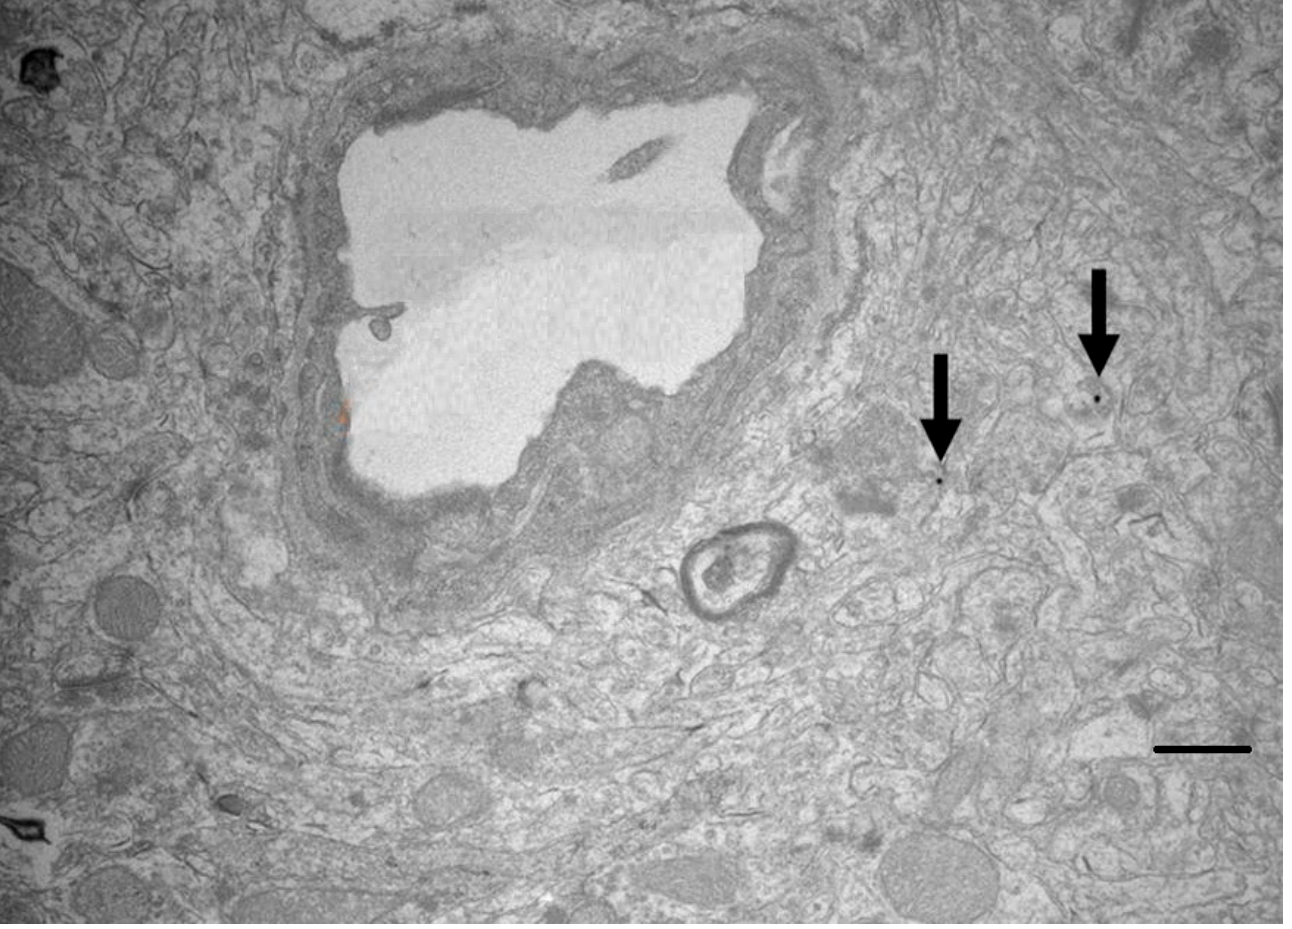
Figure 3. TEM silver-enhanced image showing transport of 7-nm gold glyconanoparticles carrying 40 bp dsDNA oligonucleotide (arrows) into the cortex of the rat brain 10 min after infusion into the carotid artery. Scale bar = 500 nm. Image is courtesy of Dr. Nayab Fatima.